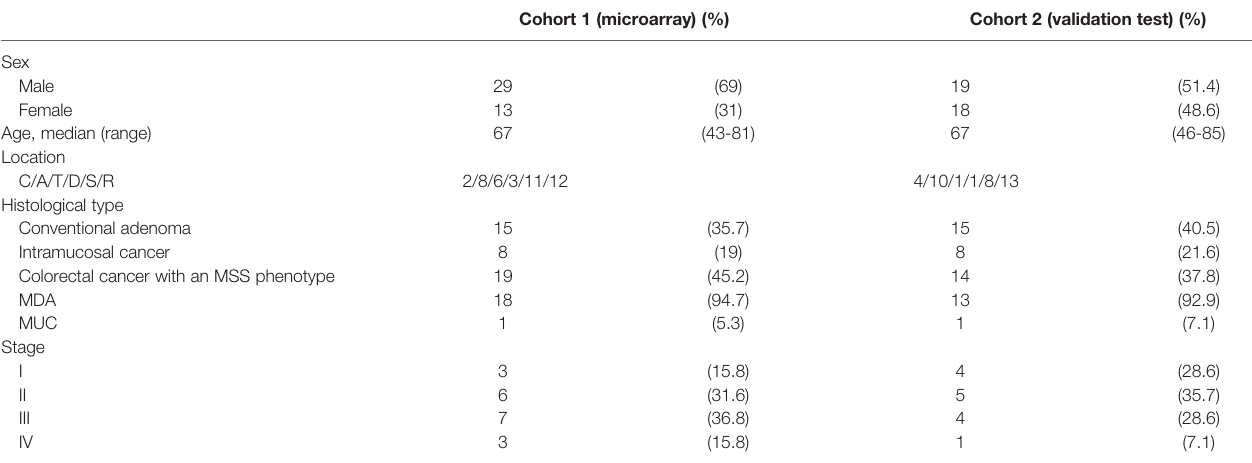
TABLE 1-A | Clinicopathological fi ndings of the colorectal